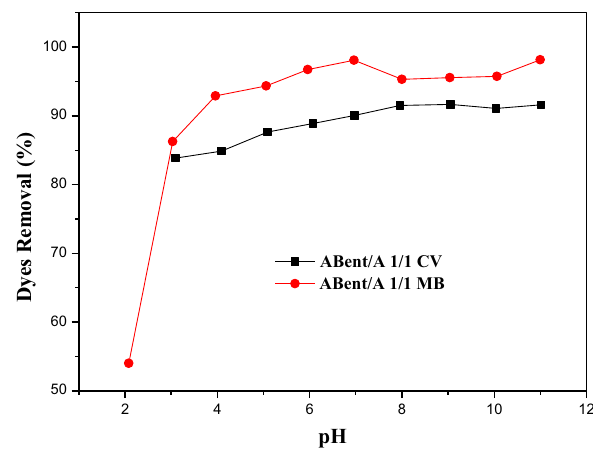
Fig. 7 pH impact on the adsorption of dyes on ABent/A ( C 0 = 100 mg/L, m ABent/A = 10 mg, V ABent/A = 10 mL, Agit = 200 rpm, T = 25